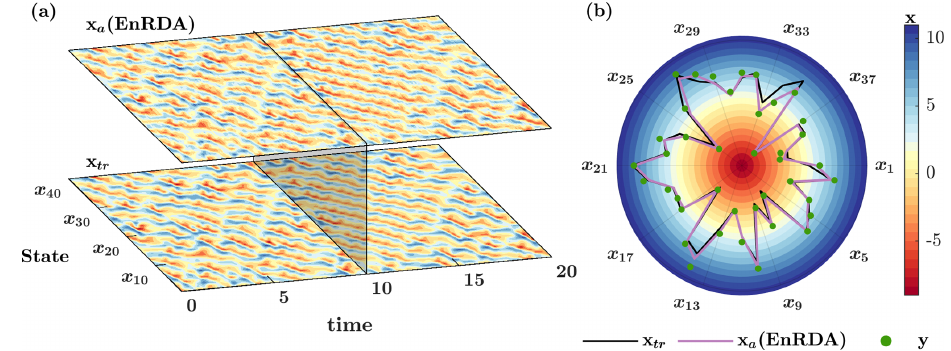
Figure 2. (a) Temporal evolution of the ground truth x tr and analysis state x a by ensemble Riemannian data assimilation (EnRDA) for K = 40 dimensions of Lorenz-96 over T = 0–20 (t) and (b) their snapshots at T = 10 (t) together with the available observations y .